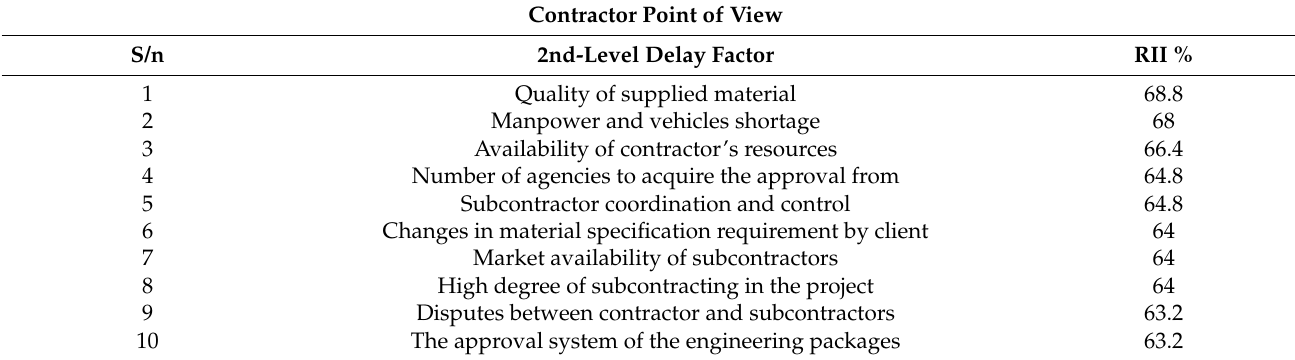
Table 11. Root cause in contractor point of view.